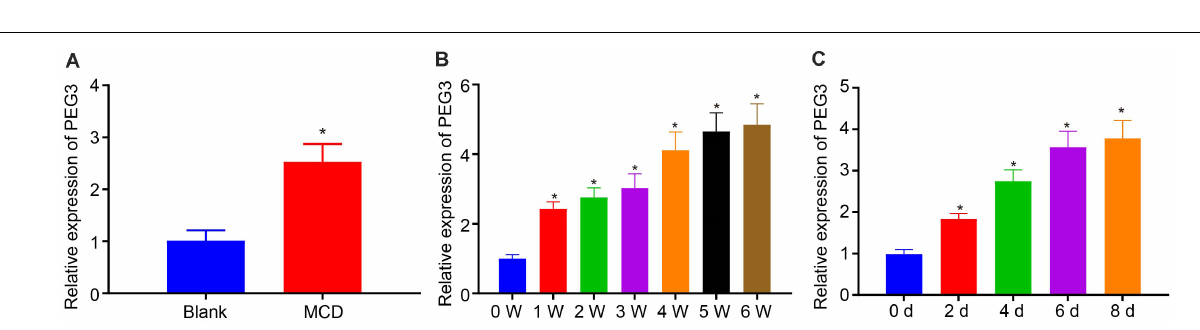
Frontiers in Genetics |